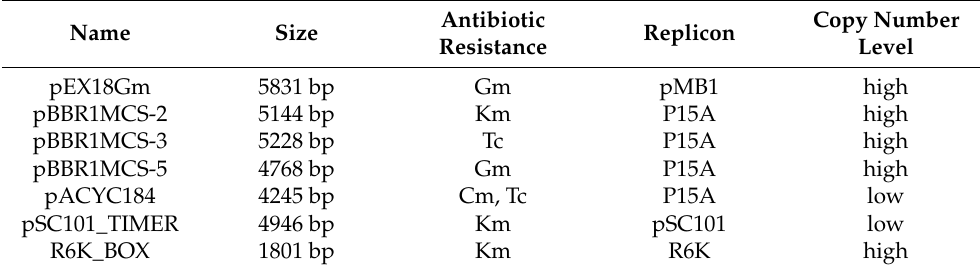
Table 1. Plasmid information used in this